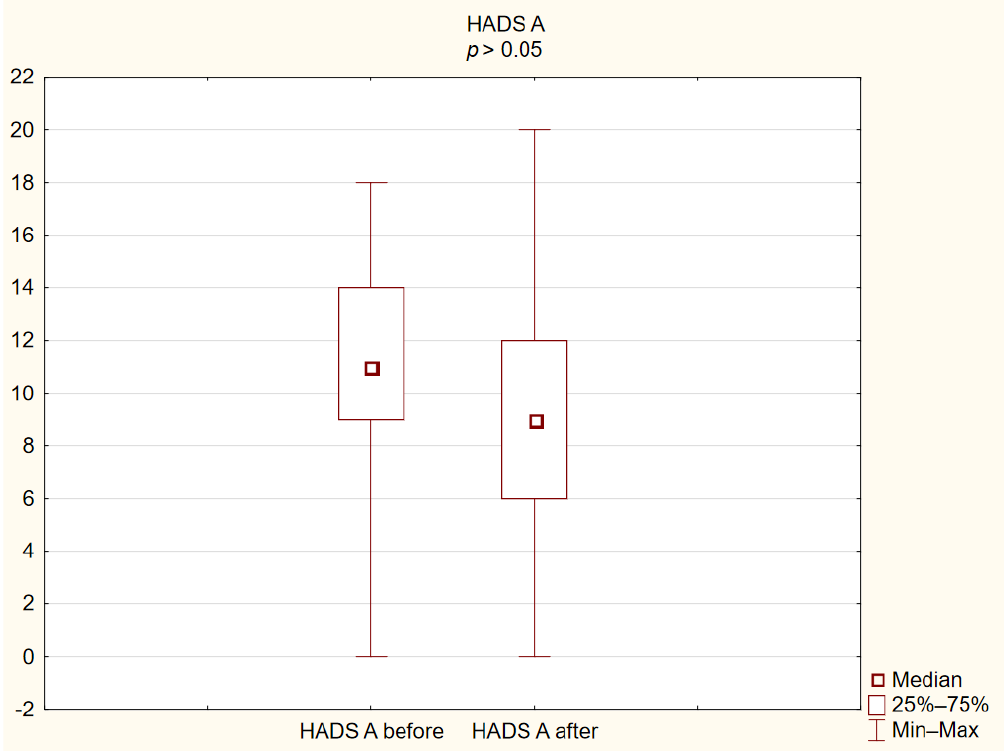
Figure 4. Worsening of symptoms of anxiety before and after the rehabilitation program, Wilcoxon test.